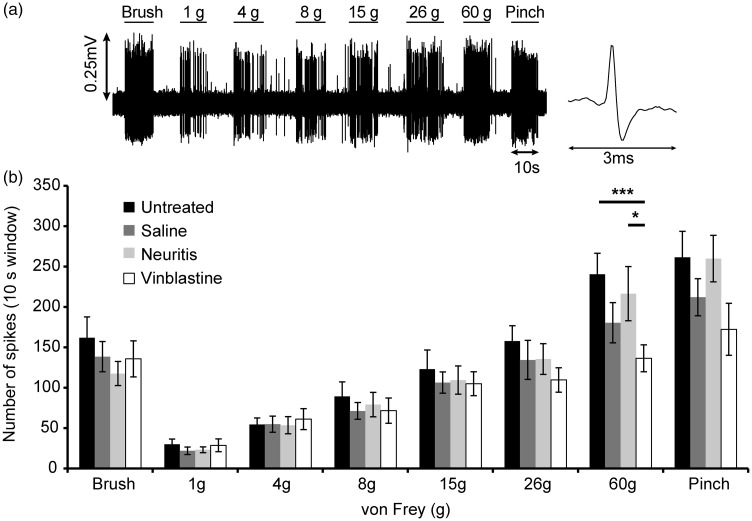
Responses of WDR neurons to mechanical stimulation of the receptive field. (a) An example trace from a saline-treated animal, which shows action potentials evoked by lightly brushing the receptive field, applying von Frey hairs of ascending stiffness and pinching the skin with curved forceps. (b) The mean number of action potentials elicited by brushing, von Frey monofilaments and pinching the skin in untreated, saline-treated, neuritis and vinblastine-treated animals. Note the decreased response to stiffer von Frey monofilaments and pinching in the vinblastine-treated group. n = 19, 18, 20 and 13 WDR neurons in the untreated, saline-treated, neuritis and vinblastine-treated group respectively. *p < 0.05, ***p < 0.001 (two-way ANOVA followed by Bonferroni’s post hoc tests). Error bars = SEM.SEM: standard error of the mean.